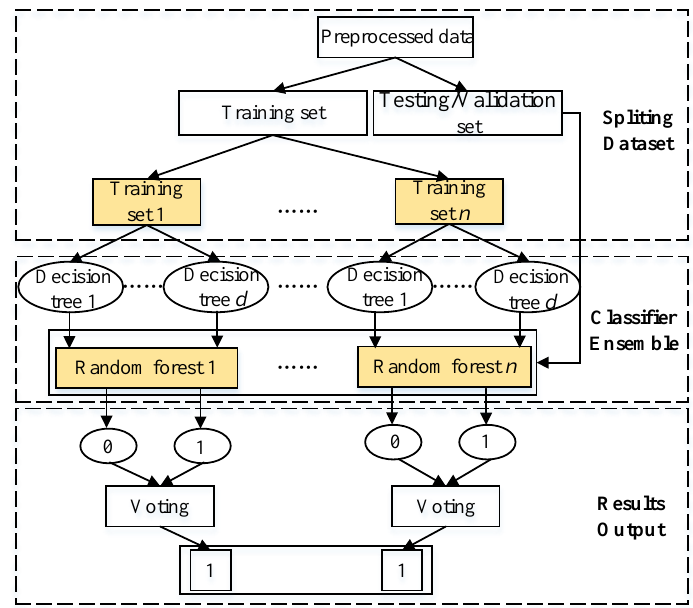
Figure 3. Implementation of